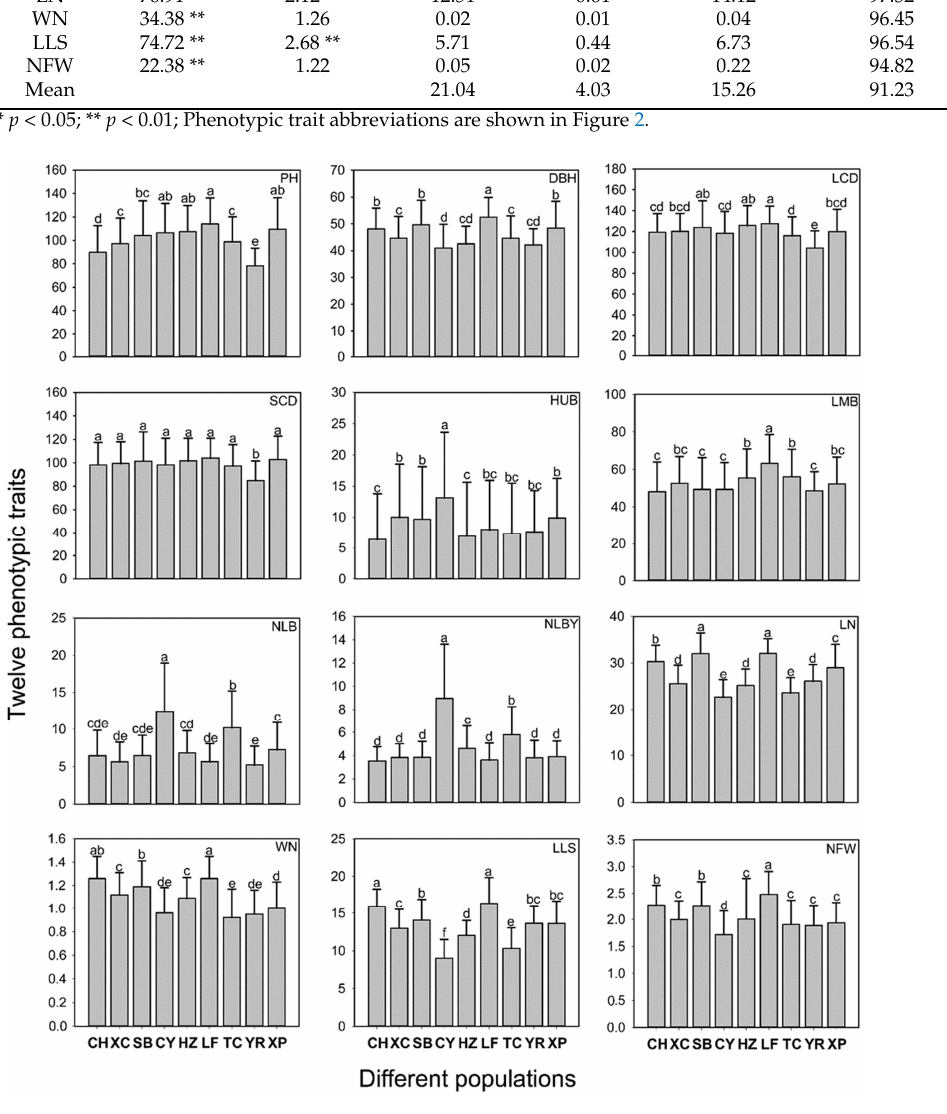
Figure 2. Phenotype traits and multiple comparisons of nine P. yunnanensis populations. Different letters in each graph indicate significant differences at p < 0.05 based on Duncan’s multiple comparisons and difference test. Error bar represents SD. PH, plant height; DBH, diameter breast height; LCD, long crown diameter; SCD, short crown diameter; HUB, height under the branches; LMB, length of the main branch of the year; NLB, number of lateral branches; NLBY, number of lateral branches of the year; LN, length of needles; WN, width of needles; LLS, length of leaf sheath; NFW, needles fascicles width. Population abbreviations and phenotypic trait abbreviations are shown in Table 1.